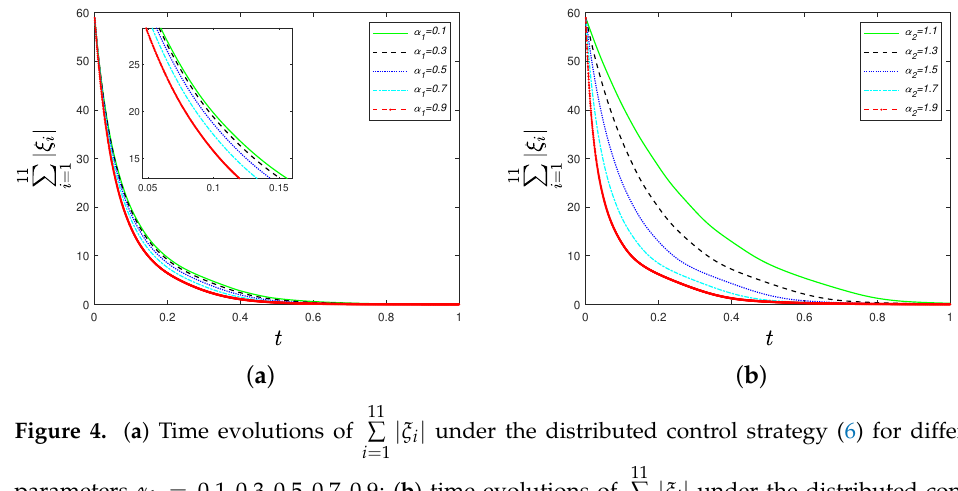
11 ∑ | ξ | under the distributed control i i = 1